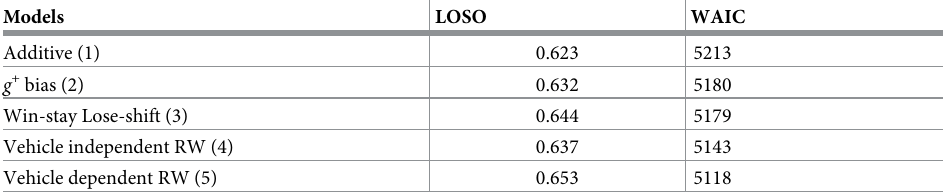
Table 2. Model comparison for DGTs. We report out of sample subject-wise likelihoods (LOSO scores) and WAIC scores for all our models (lower scores are better). Starting from the easiest (additive), which forms the basis for all our models, to the most complex (and best performing). LOSO and WAIC only disagree over models 3 and 4, with WAIC preferring number 4. Models LOSO WAIC Additive (1) 0.623 5213 0.632 5180 Win-stay Lose-shift (3) 0.644 5179 Vehicle independent RW (4) 0.637 5143 Vehicle dependent RW